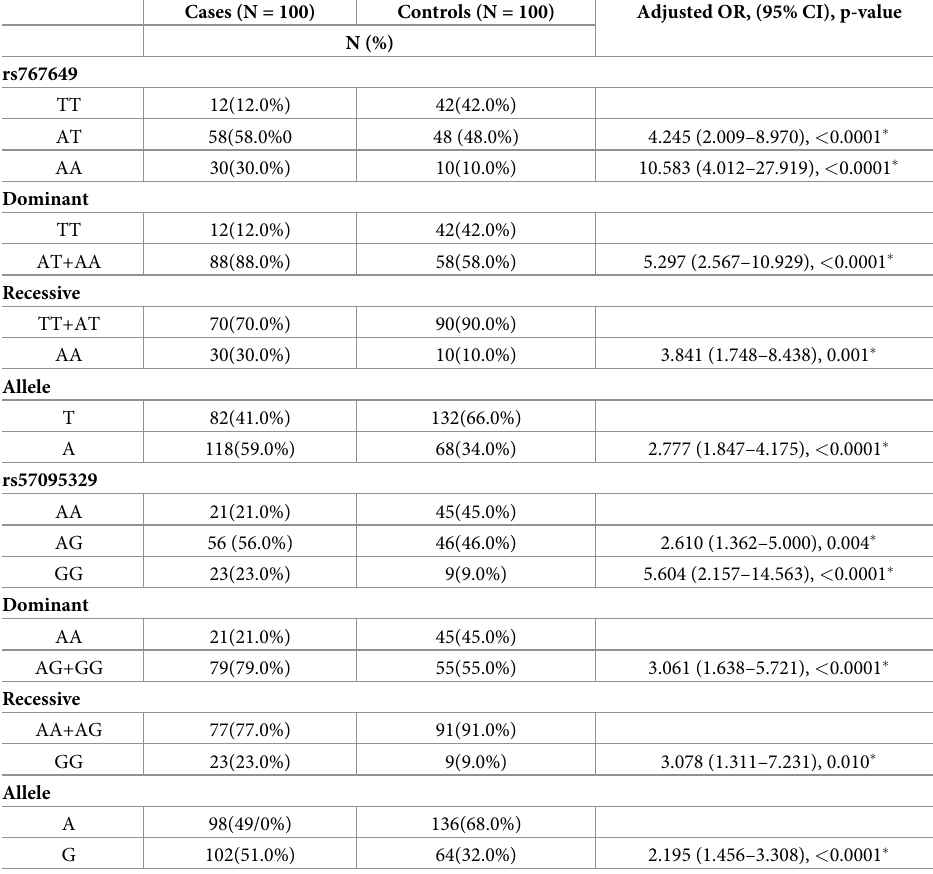
Table 2. Analysis of the frequency and association between miR-155 T/A polymorphism (rs767649) and miR- 146a A/G (rs57095329) and susceptibility to chronic hepatitis B viral